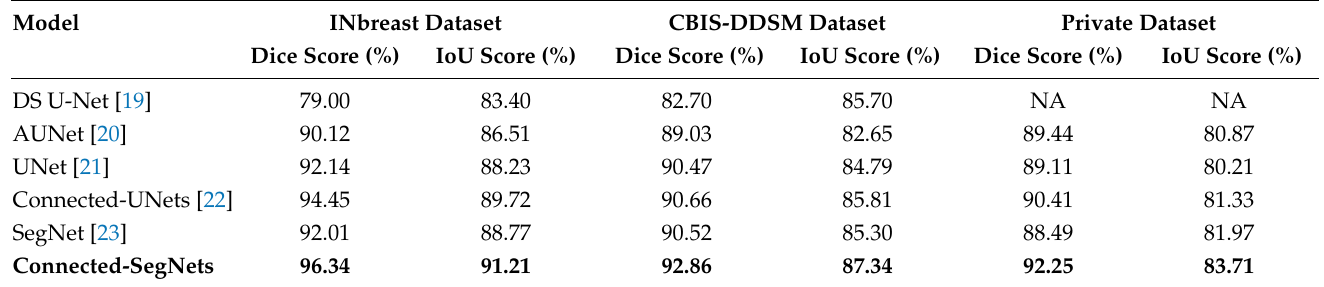
Table 7. Comparison results between the proposed Connected-SegNets and the related